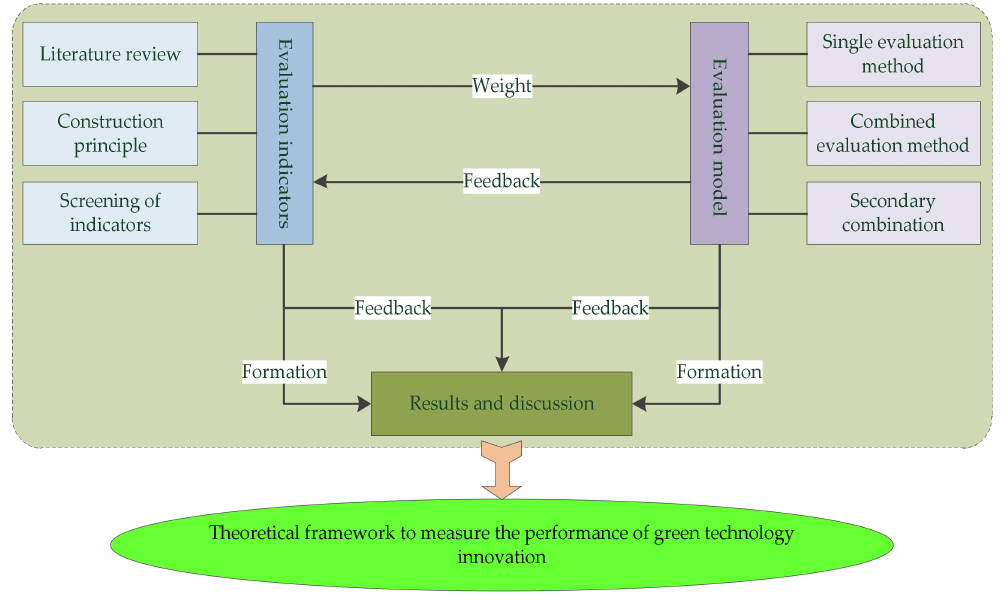
Figure 1. The analytical framework of green technology innovation performance evaluation of manufacturing enterprises under multi-agent